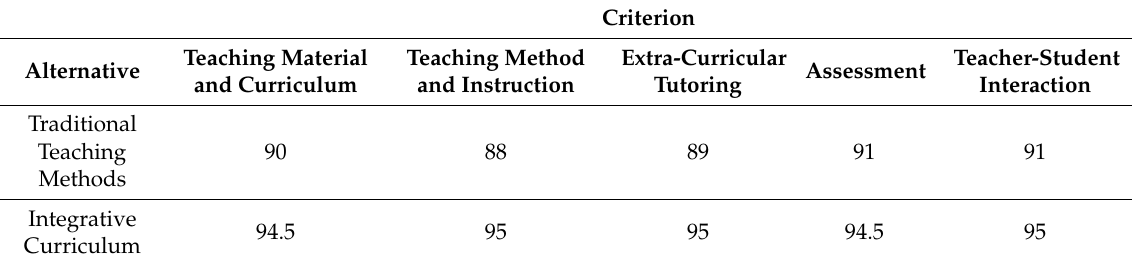
Table 4. The decision matrix for the technique for order preference by similarity to ideal solution